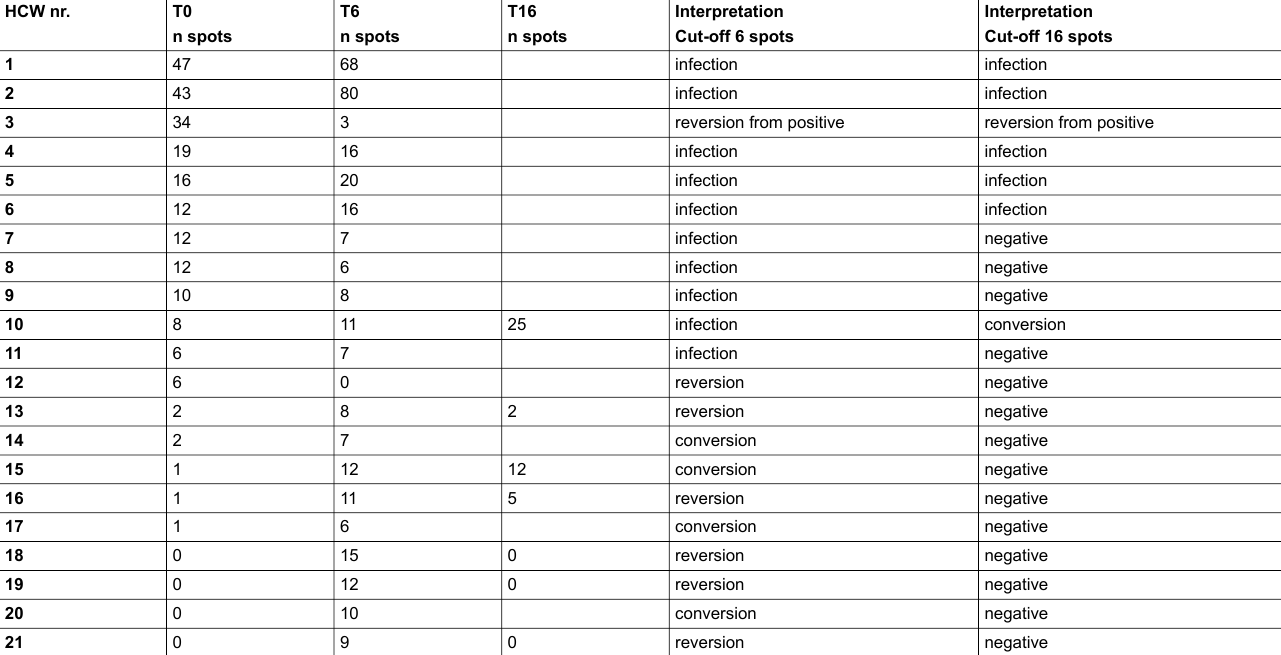
Table 2: Evolution of the number of spots between T0 and T6 among all HCW who had at least one positive test result with the current definition of cut-off (six and more spots) and with a modified cut-off (16 spots and more). Contacts with positive IGRAs at T0 were considered as having a prior infection of unknown origin, contacts with a change from negative to positive were considered as possible conversions, contacts with a change from positive (at T0 or T6) to negative (at T6 or T16) were interpreted as reversion. HCW